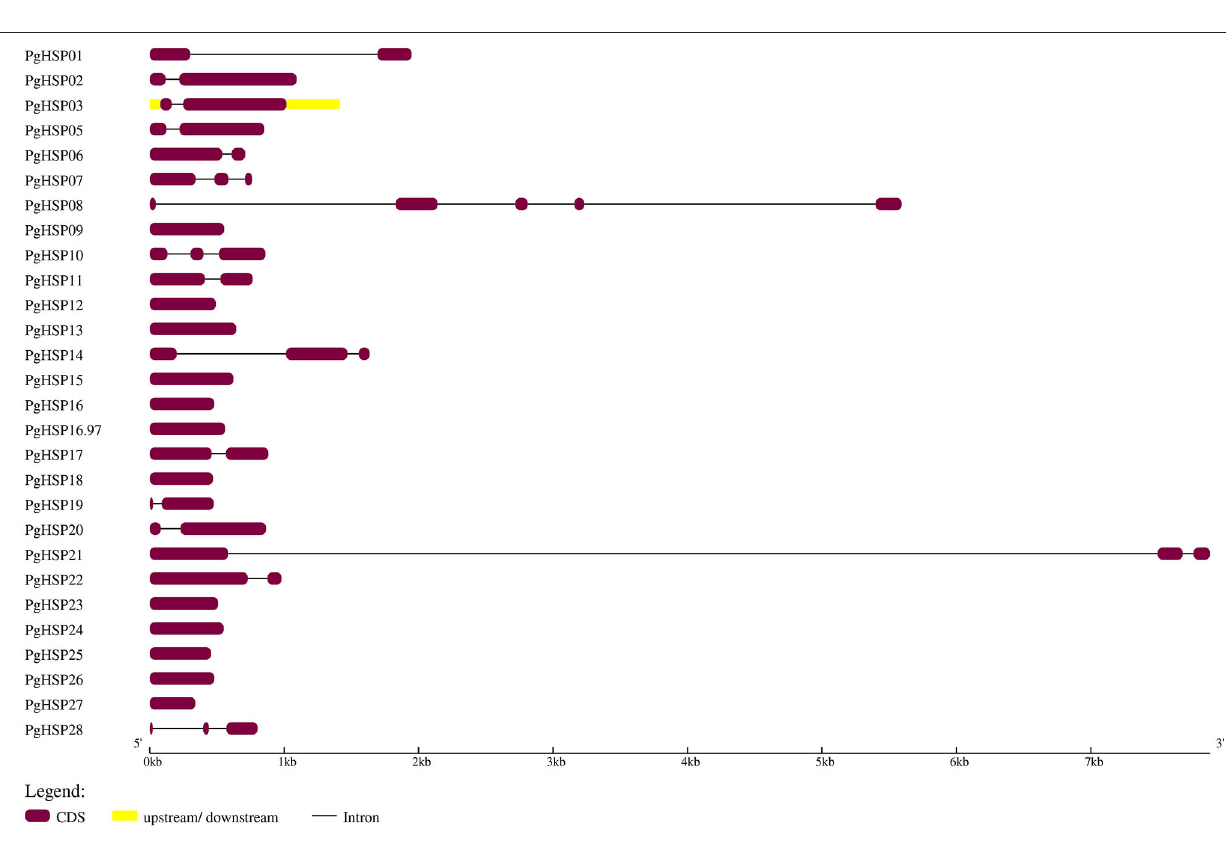
Frontiers in Plant Science |